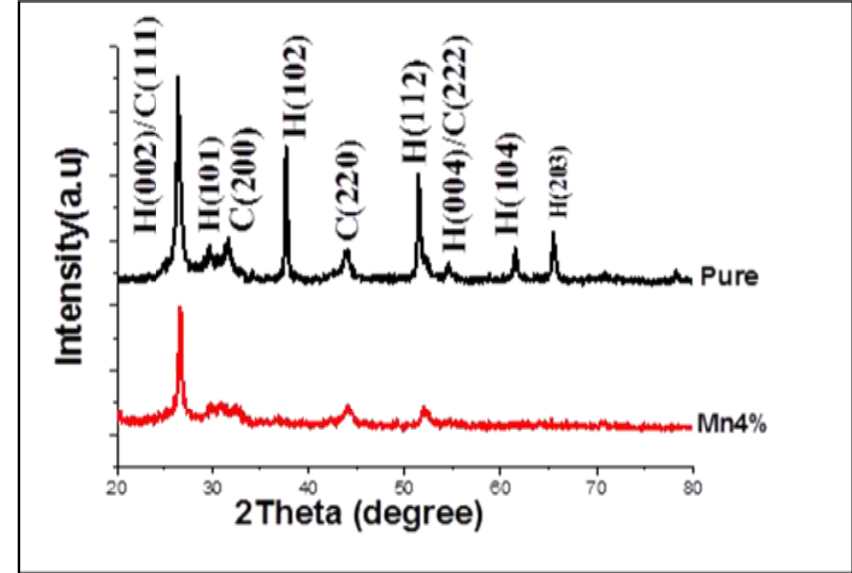
Figure 2: XRD pattern of CdS film prepared by hydrothermal